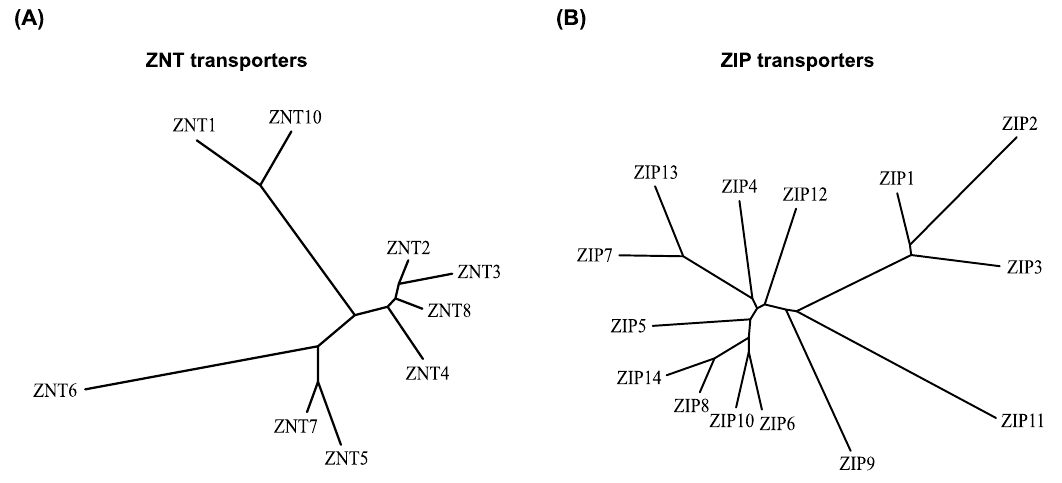
Figure 2. Phylogeny of ZNT and ZIP transporters. The neighbor-joining phylogenetic tree was constructed using ClustalW (http://clustalw.ddbj.nig.ac.jp/index.php?lang=en) protein alignment.